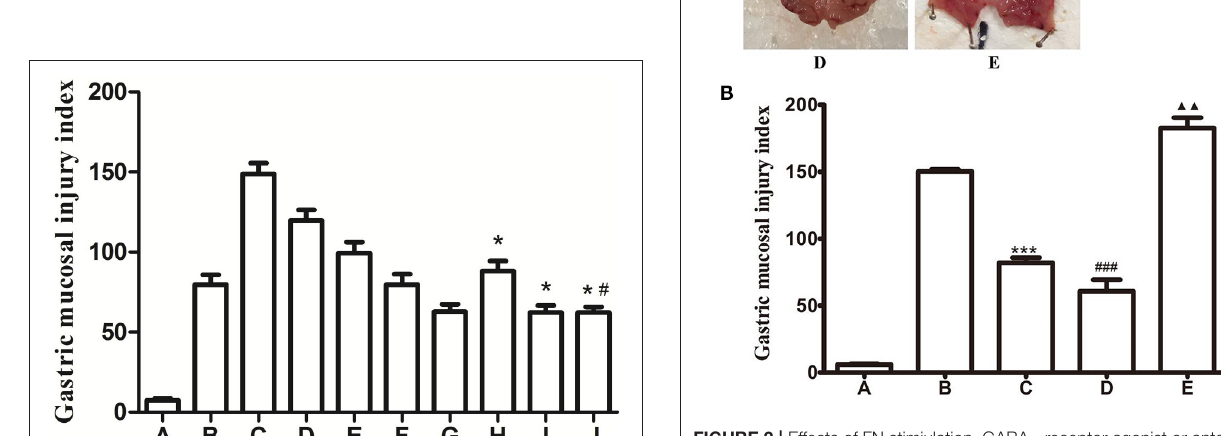
FIGURE 2 | Effects of FN stimiulation, GABA B receptor agonist or antagonist microinjected into LHA on GI-R injury. (A) Representative macroscopic photograph of gastric tissue in different groups; (B) Effects of chemical stimulation of FN or microinjection of GABA B receptor agonist or antagonist into LHA on GI-R injury in rats. *** P < 0.001, as compared with the GI-R group; ### P < 0.001, as compared with the GI-R group; NN P < 0.01, as compared with the GI-R group. A, Normal group; B, GI-R group; C, FN + GI-R + L -Glu group; D, LHA + GI-R + Baclofen group; E, LHA + GI-R + CGP35348 group. n =